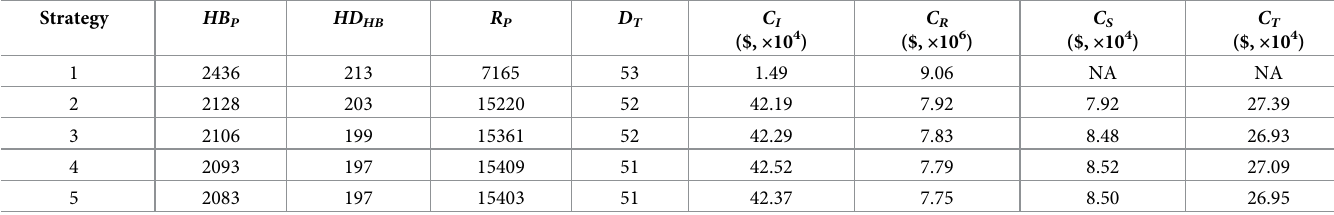
Table 5. Population stats in La´brea municipality in 2027 under five different strategies.